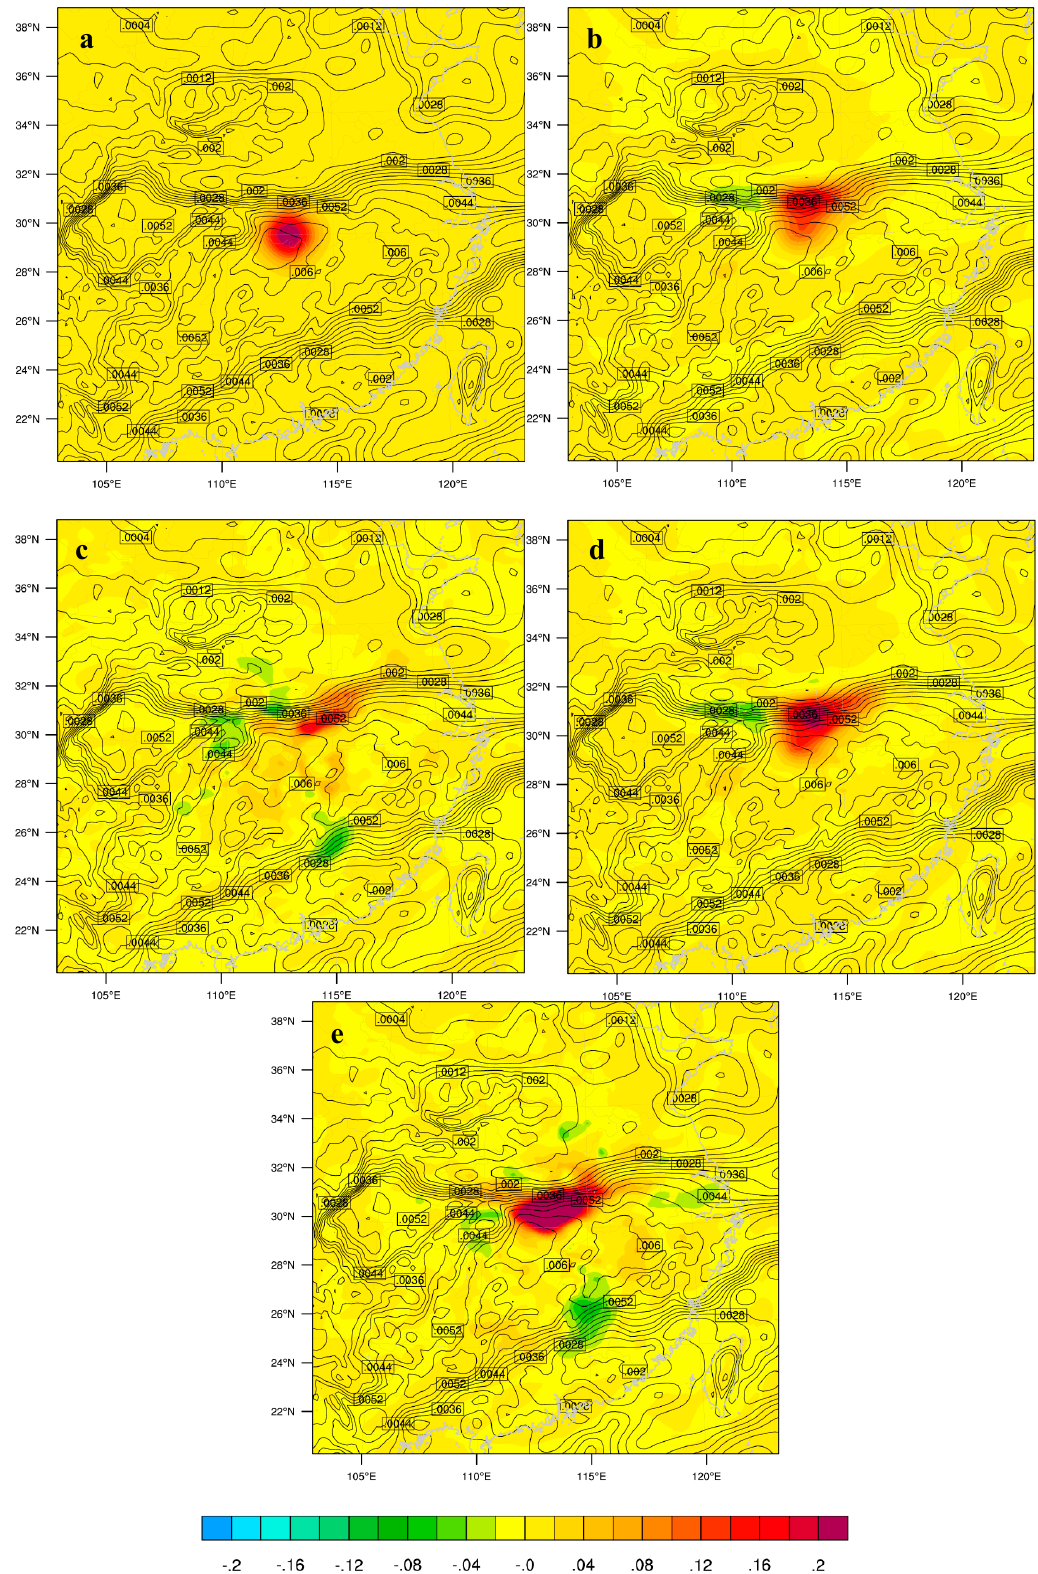
Figure 5. The analysis increments of the water vapor mixing ratio (shaded; kg/kg) of the single observation test. The weight coefficient of the ensemble error covariance is 100%. The localization scale is 400 km. The solid black lines are contours of the background water vapor mixing ratio at analysis time. ( a . 3DVar; b . RE20-HDA; c . GE-HDA; d . GE/RE-HDA; e . RE60-HDA).